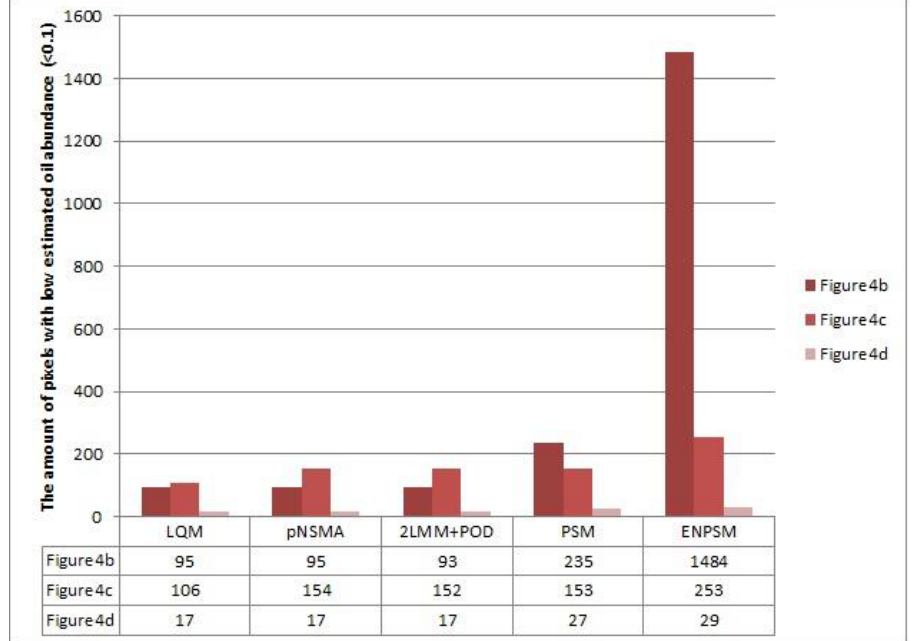
Figure 9. Amount of pixels with low oil fractional abundance (the corresponding estimated value < 0.1) of Figure 4b–d derived from five unmixing method: LQM, pNSMA, 2LMM with POD, PSM and ENPSM.